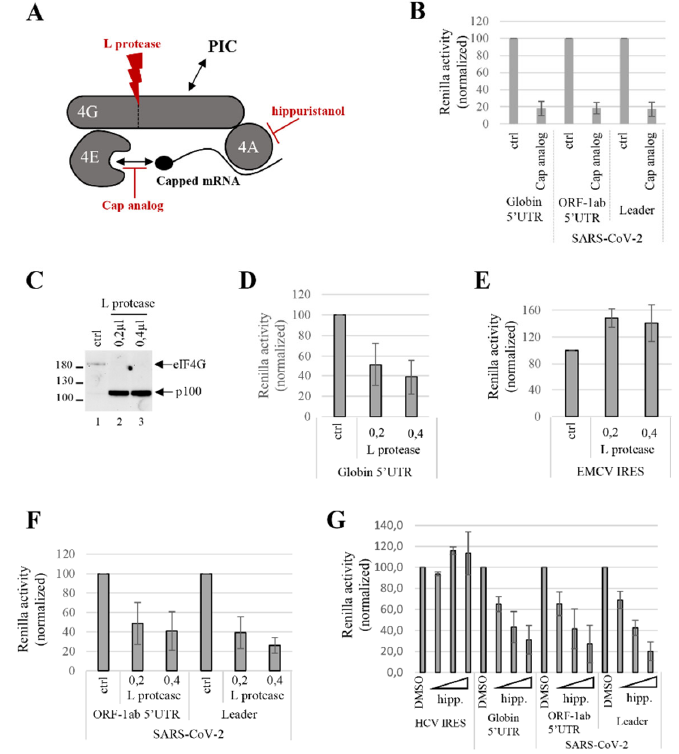
Figure 6. Requirement for the eIF4F complex. ( A ) Schematic cartoon of the eIF4F complex, which is composed of eIF4E, eIF4G and eIF4A. The interactions with the PIC, cap analog, L protease and hippuristanol are depicted on the figure. ( B ) RRL was treated with cap analog (1 μ M) or with water (ctrl) and then programmed with capped and polyadenylated globin ‐ Renilla and SARS ‐ CoV ‐ 2 leader or 5 ′ UTR ORF1ab ‐ Renilla mRNAs. Products of expression were quantified by luciferase assays and normalized to the control condition (set at 100%). ( C – F ) Untreated RRL was pre ‐ incubated alone (ctrl) or in presence of different amounts of L protease ( μ L) as indicated, and then programmed with ( D ) globin ‐ Renilla, ( E ) EMCV IRES ‐ Renilla, ( F ) SARS ‐ CoV ‐ 2 leader or 5 ′ UTR ORF1ab ‐ Renilla mRNAs. Translation products were ( C ) resolved by a 7.5% SDS ‐ PAGE and then transferred to a PVDF membrane for Western blotting analysis against eIF4G, or ( D – F ) analyzed by luciferase assay and normalized to the control condition (set at 100%). ( G ) RRL pre ‐ treated with DMSO or increasing amounts ( μ M) of hippuristanol (hipp.) was programmed for 30 min with globin ‐ Renilla, HCV ‐ IRES Renilla, SARS ‐ CoV ‐ 2 leader or ORF ‐ 1ab 5 ′ UTR ‐ Renilla mRNAs. Expression products were analyzed by luciferase assay and normalized to the control condition (set at 100%). Values shown are the mean (+/ − S.D.) for three independent experiments.